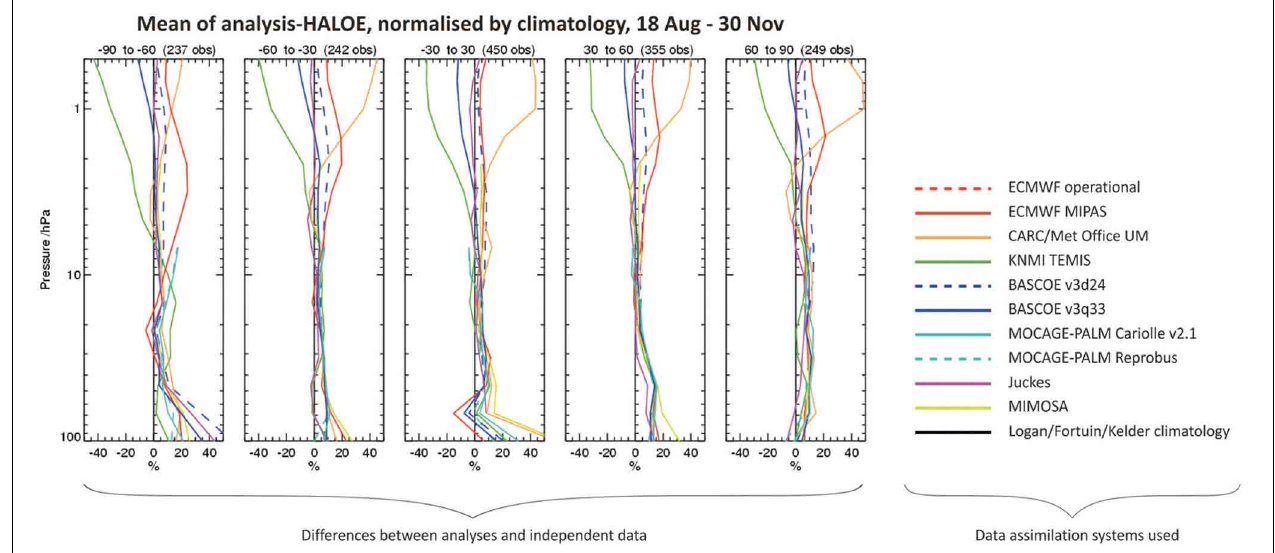
FIGURE 7 | Left section (5 panels): mean of ozone analyses minus ozone data from the HALOE (Halogen Occultation Experiment) instrument, normalized by climatology, and shown as a percentage of the climatology. The period considered is 18 August–30 November 2003 and